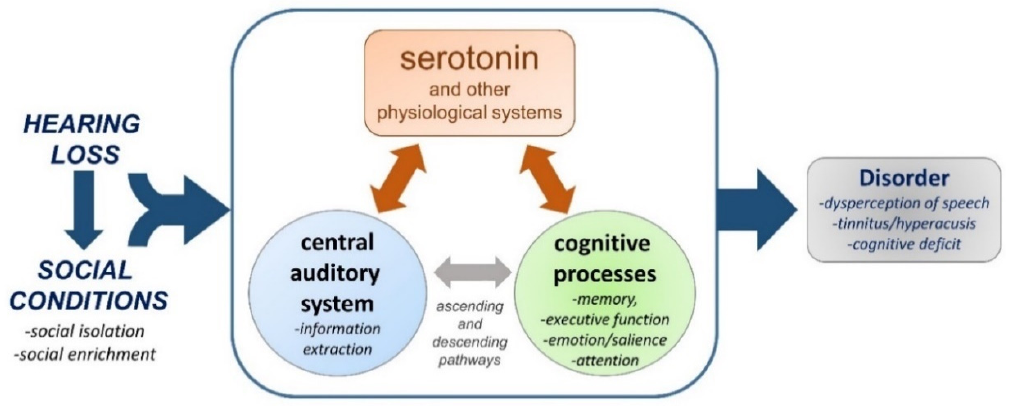
Figure 3. Conceptual diagram of the serotonergic system as a regulator of interacting neural systems that are affected by hearing loss and social isolation. Plasticity in the regulation of interacting auditory and extra-auditory circuitry by serotonin could lead to consequences for perceptual and affective auditory responses to sound.